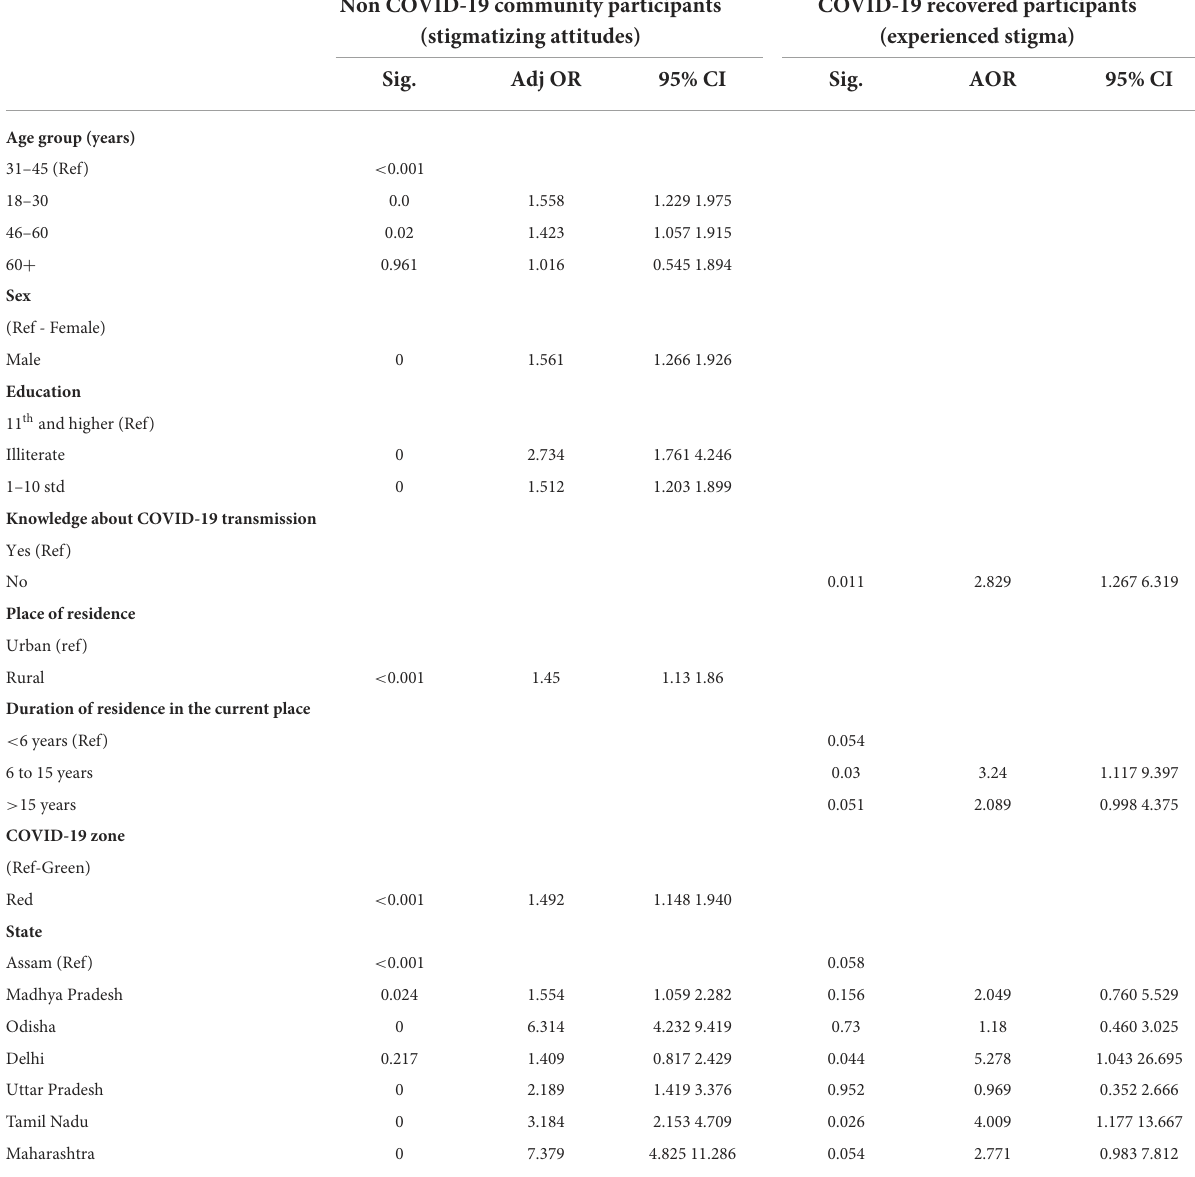
TABLE 3 Factors associated with stigma experience among the COVID-19 recovered participants and stigmatizing attitude among non-COVID-19 community participants (multivariate analysis). Non COVID-19 community